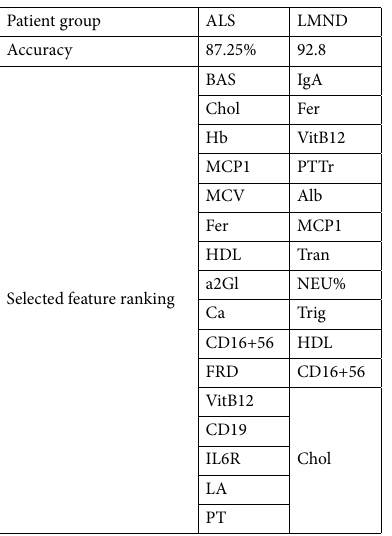
Table 5. List of the most informative features selected by the SVM-RFE for each High PR/Low PR classification